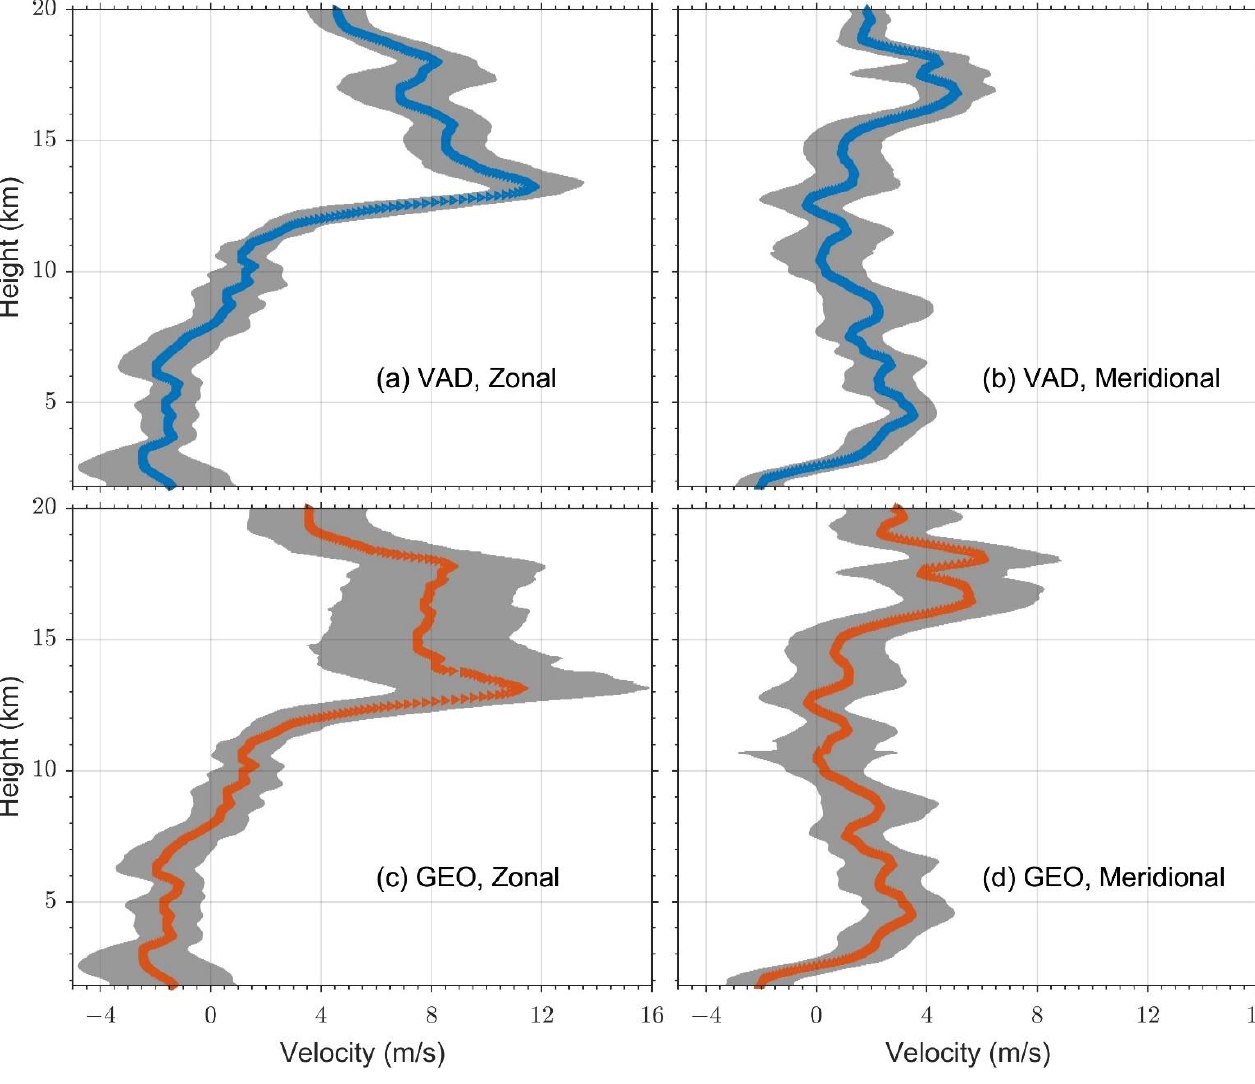
Figure 5. Daily mean height distribution of zonal wind ( a , c ) and meridional wind ( b , d ) derived by the VAD ( a , b ) and GEO ( c , d ) methods during 17 – 18 July 2021, in experiment #2. The shaded area represents 1- σ standard deviation.